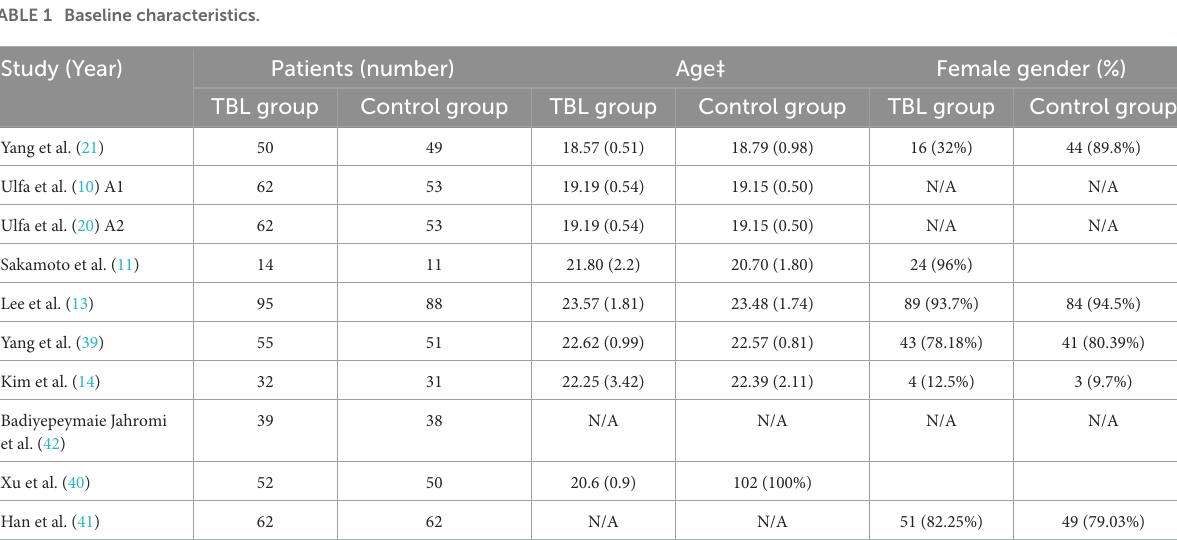
TABLE 1 Baseline